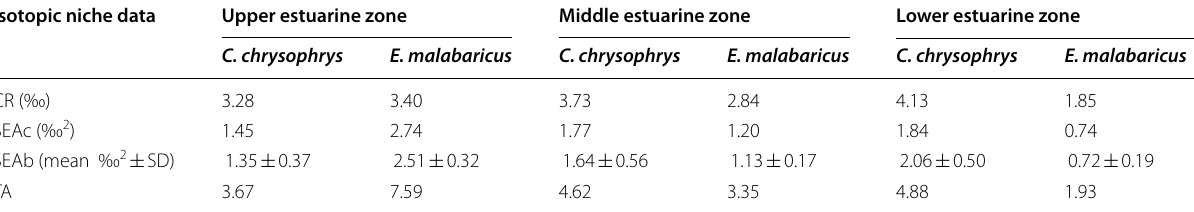
CR the δ 13 C range (difference between the smallest and largest values of δ 13 C), SEAc = estimated mean Bayesian standard ellipse area